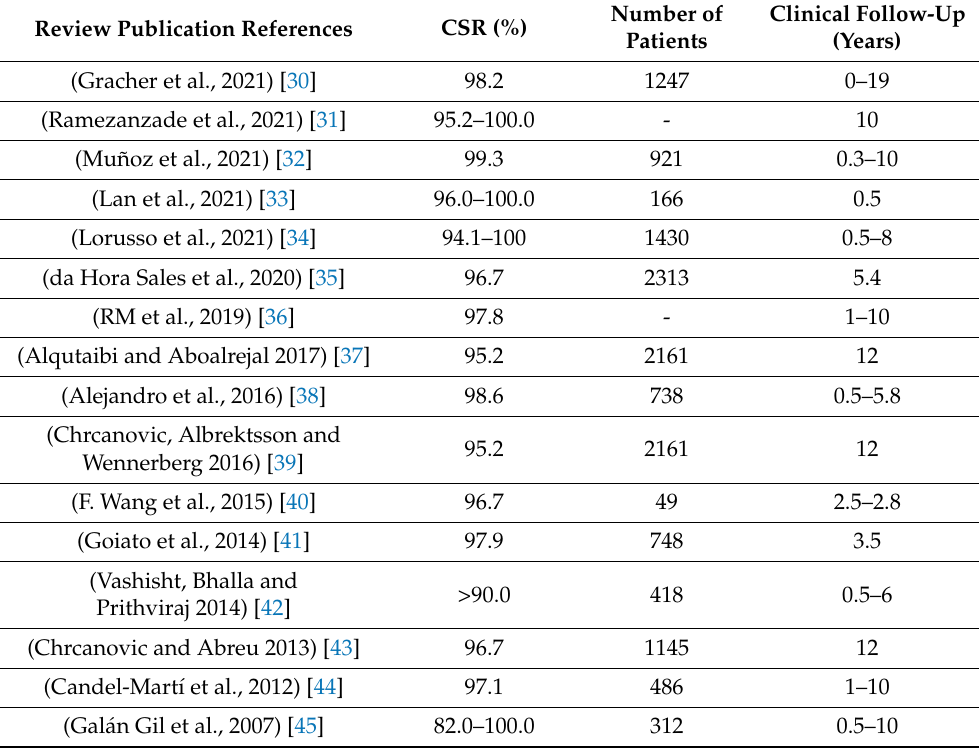
Table 2. CSR (%), number of patients and years of follow-up for